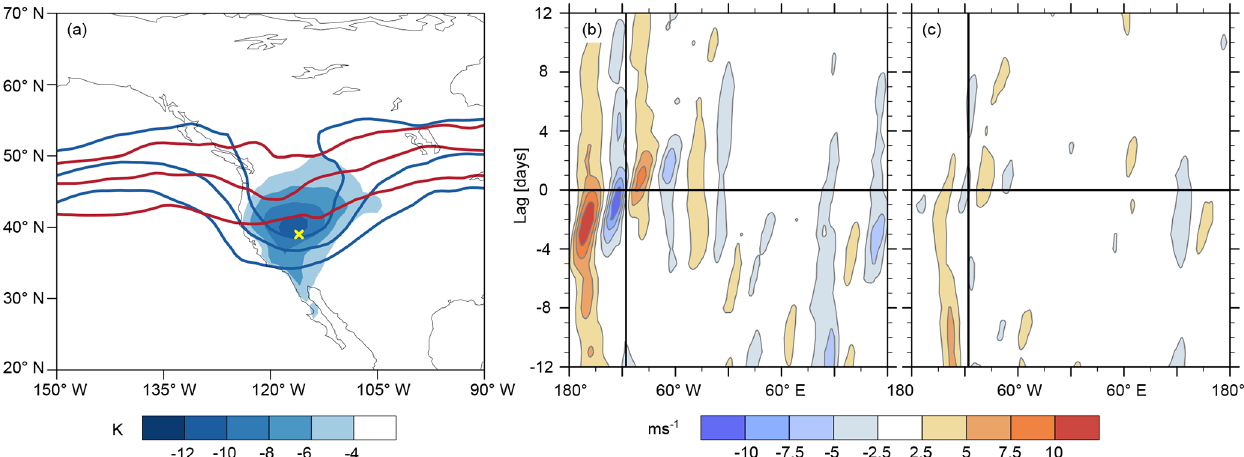
Figure 10. (a) T2m difference between the 100 climatologically coldest JJA days and the 100 coldest extreme-summer days (shading). Contours depict the composite PV field at 335K (contours of 2, 3.5 and 5 PVU) for the 100 climatologically coldest JJA days (blue) and for the 100 coldest extreme-summer days (red). The yellow cross indicates 39 ◦ N, 116 ◦ W. Panels (b) and (c) depict composite Hovmöller diagrams of the anomalous 250hPa meridional wind, averaged between 35 and 65 ◦ N, and temporally centred on the 100 climatologically coldest JJA days (b) and on the 100 coldest extreme-summer days (c) . Meridional wind anomalies are calculated relative to the 1979–2018 mean JJA meridional wind. The vertical line in panel (b) and (c) indicates 116 ◦